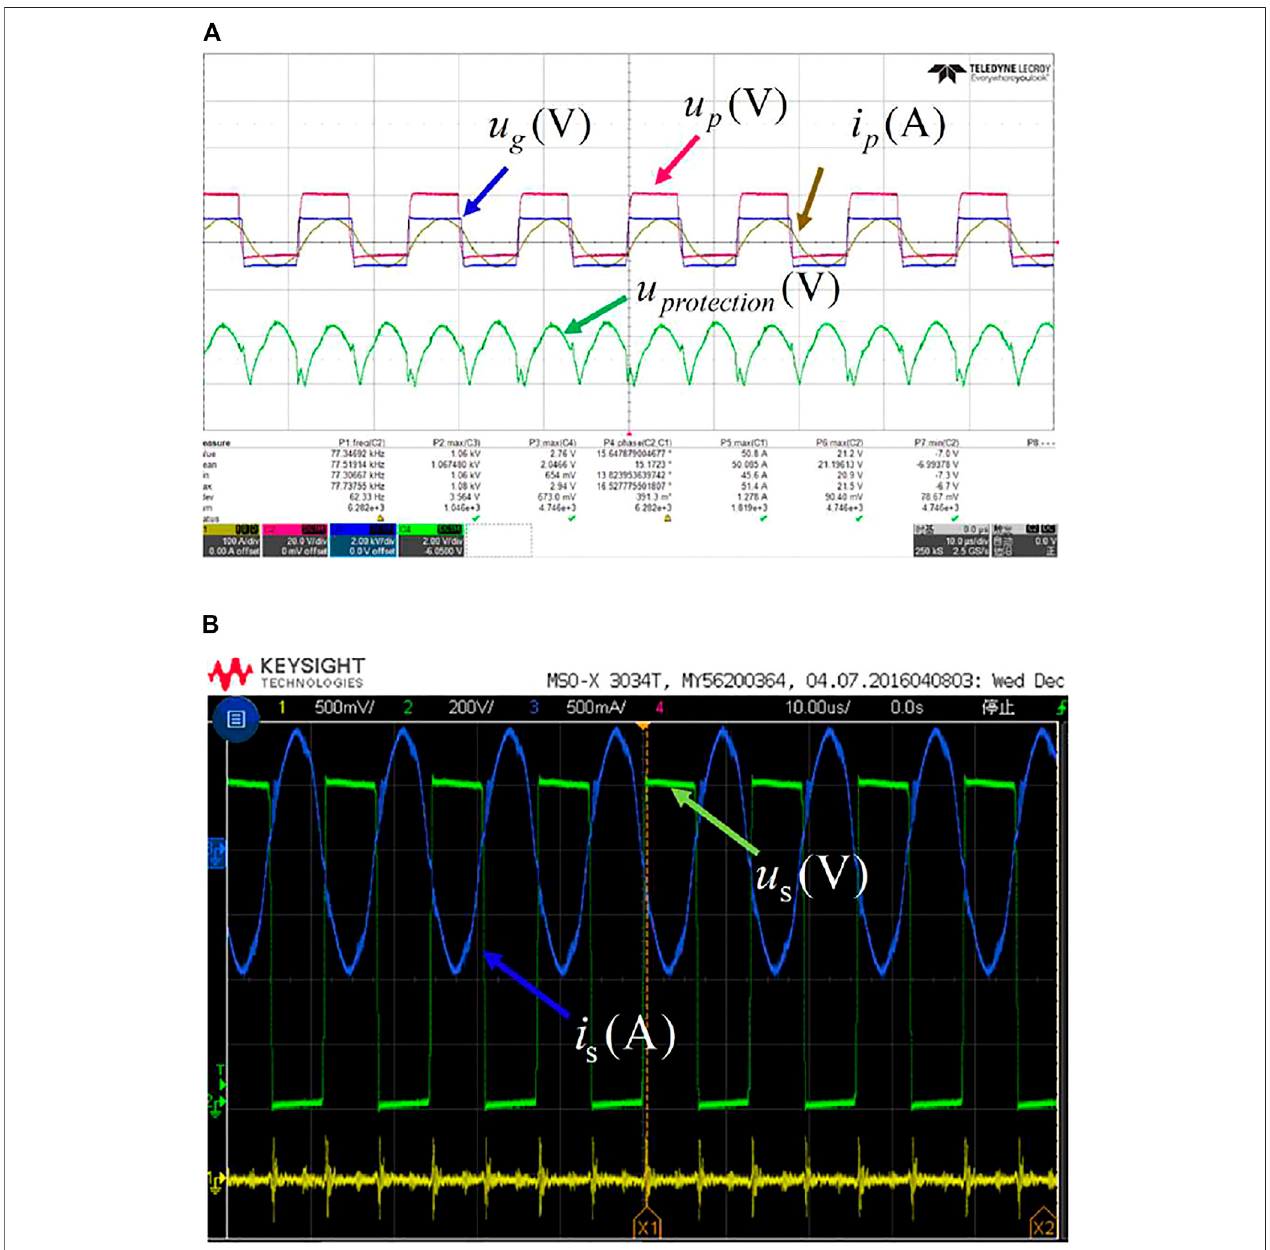
FIGURE 18 | Test waveforms of system in 30 kW. (A) Primary side; (B) Secondary